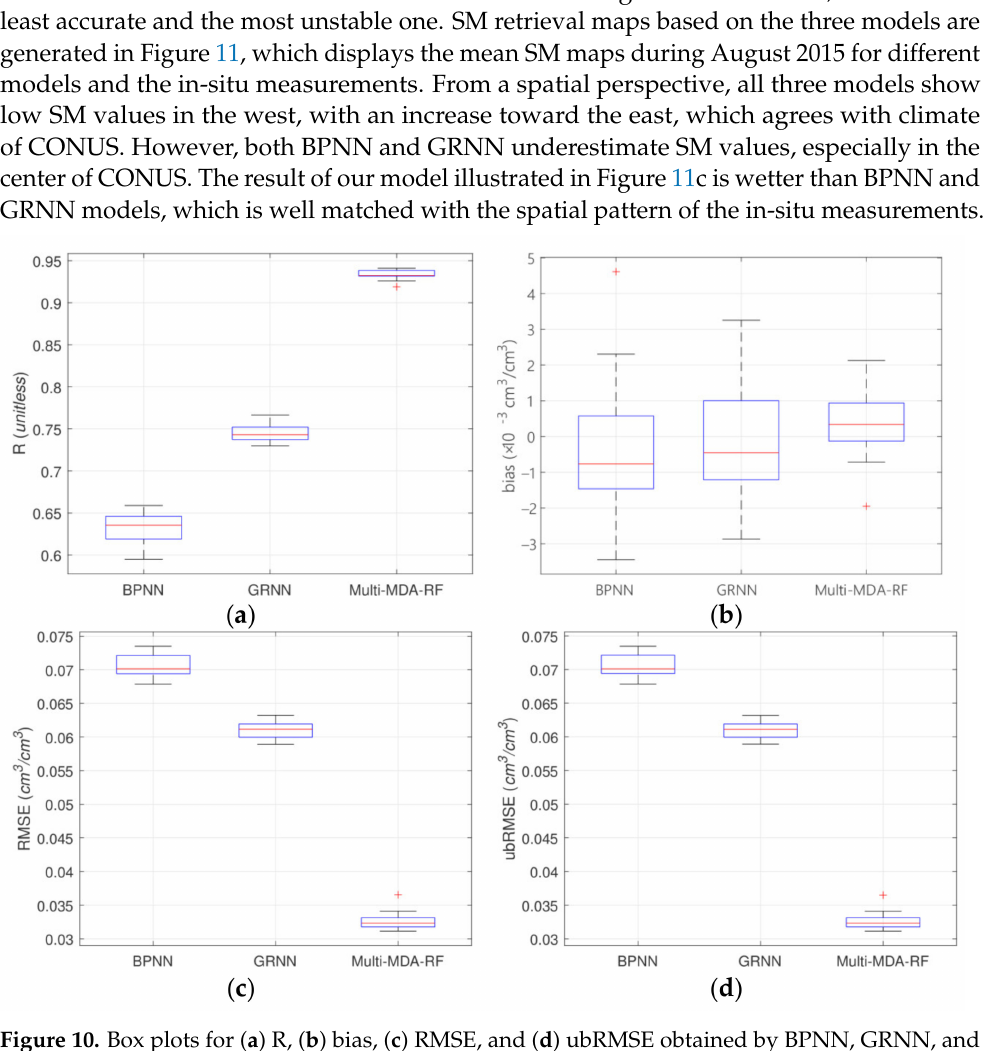
Figure 10. Box plots for ( a ) R, ( b ) bias, ( c ) RMSE, and ( d ) ubRMSE obtained by BPNN, GRNN, and Multi-MDA-RF. The central mark indicates the median, while the bottom and top edges of the box indicate the 25th and 75th percentiles, respectively. The whiskers extend to the most extreme data points not considered outliers plotted individually using the “+”